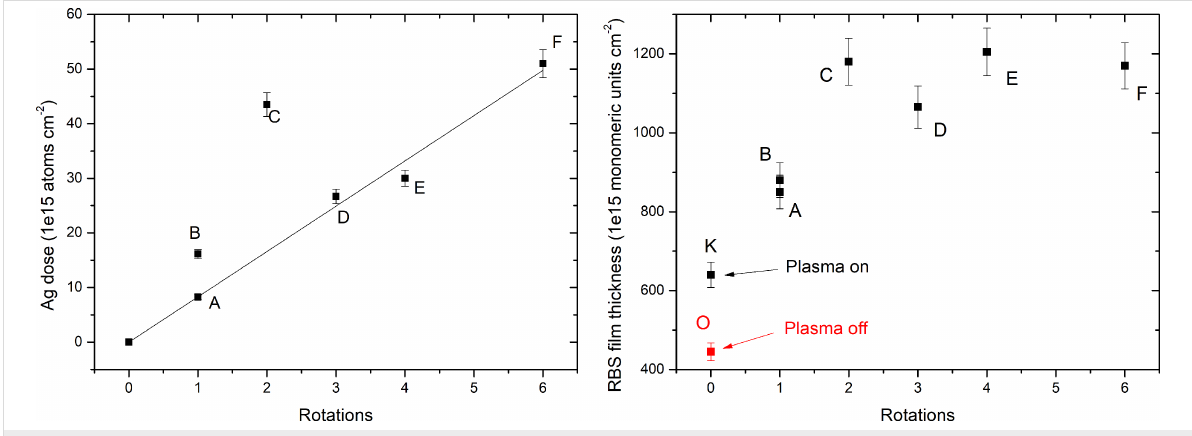
Figure 1: Ag dose (left) and film thickness (right) versus rotations.